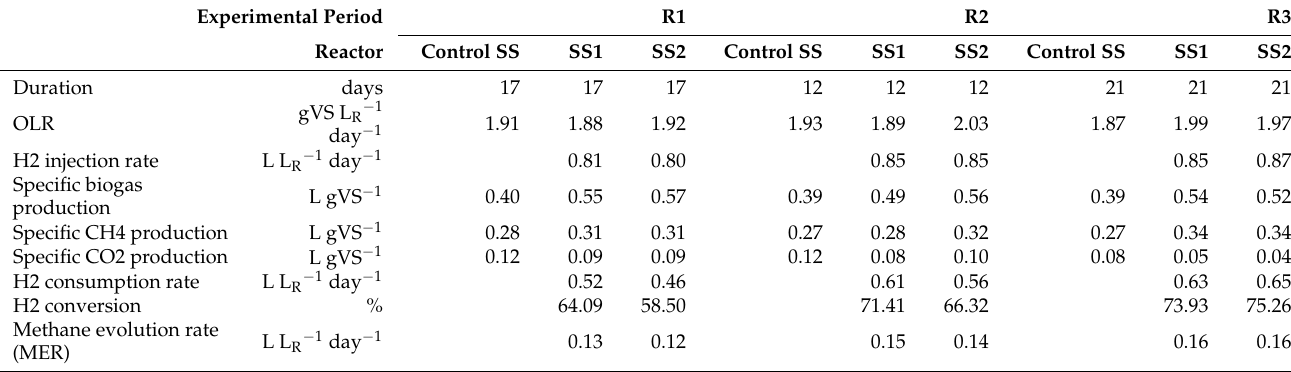
Table A4. Average in-situ biomethanation results for sewage sludge (SS)-fed reactors across opera- tional periods